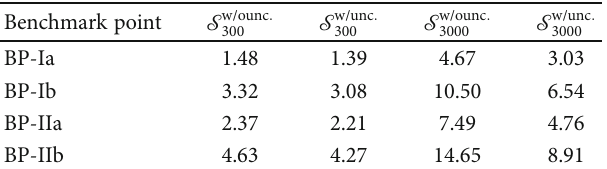
Table 7: Signi fi cances for luminosities L = 300 , 3000fb − 1 for the benchmark points of Table 6.